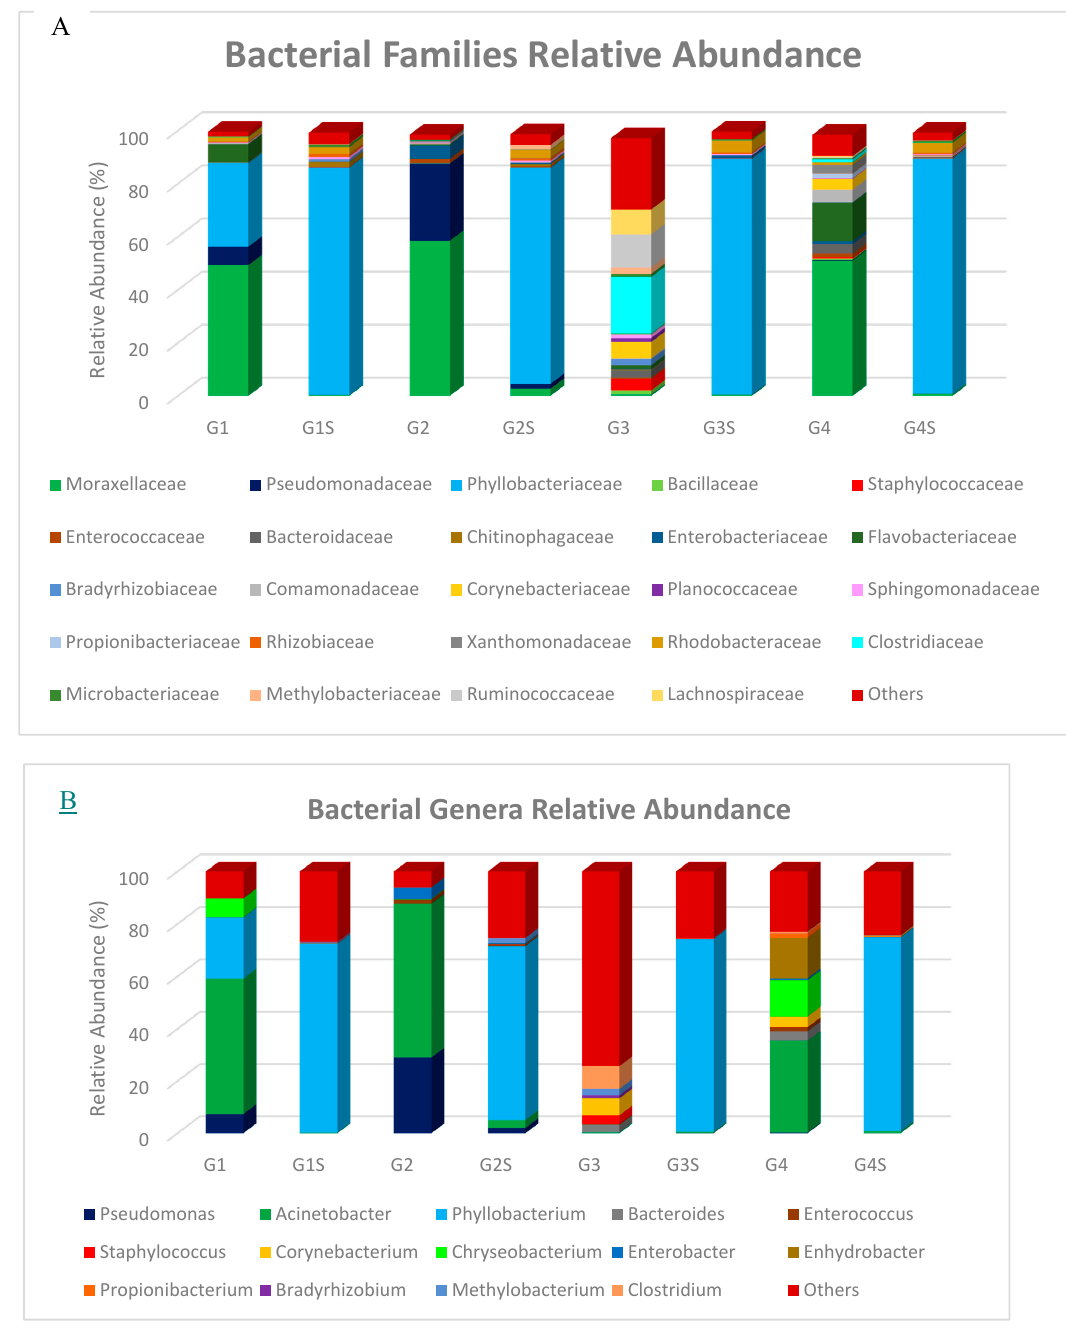
Figure 2. 3D 100% stacked column chart of the relative abundance of the major taxonomic groups detected by high-throughput sequencing (HTS) at: ( A ) family level and ( B ) genus level, for four immediately stored at − 80 ◦ C goat milk samples and the same for four that were kept O / N at 4 ◦ C (G1S, G2S, G3S and G4S). Only taxa with relative representation > 1% in at least one sample are